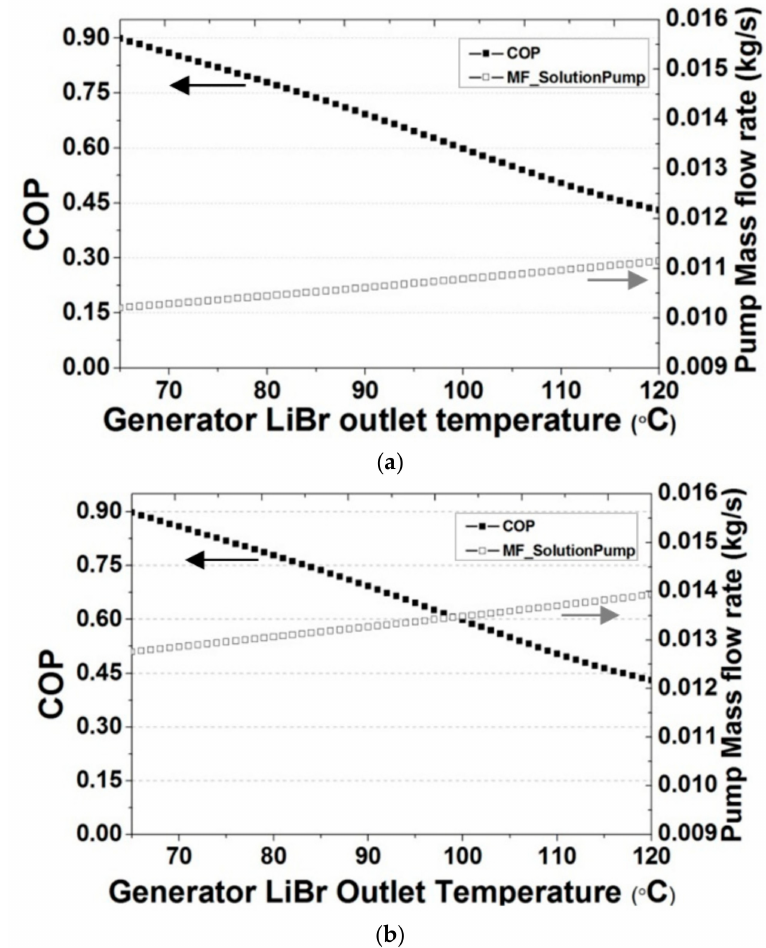
Figure 9. Comparison of cooling e ffi ciency and LiBr aqueous solution transfer rate according to the temperature of the LiBr solution at the generator outlet of absorption cooling system. ( a ) Absorption cooling capacity: 2.0 kW; ( b ) Absorption cooling capacity: 2.5